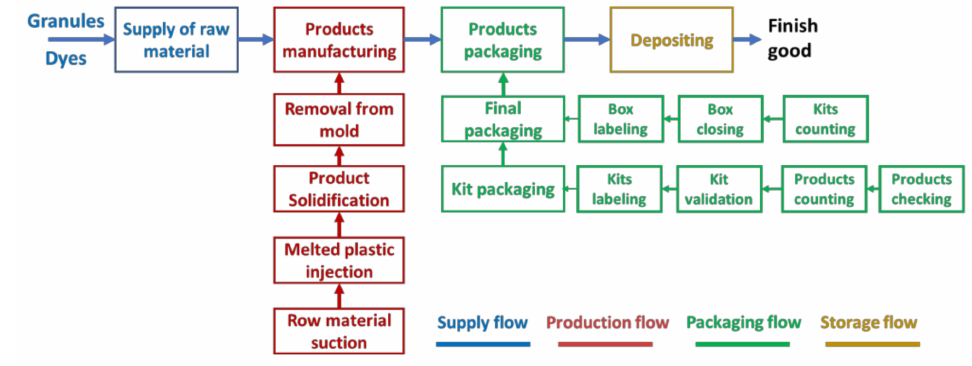
Figure 13. Production